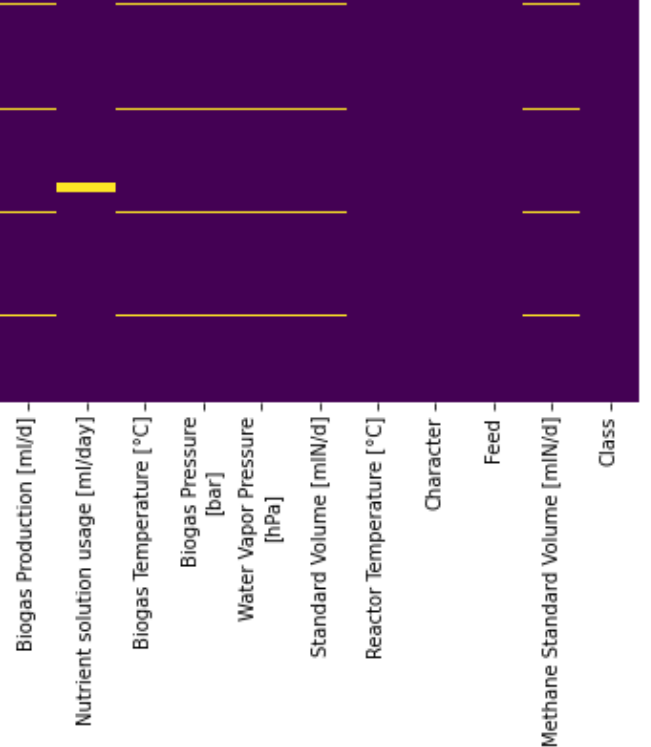
Figure 3. Defining the missing data with the help of a heatmap ( y -axis shows the data continuity).